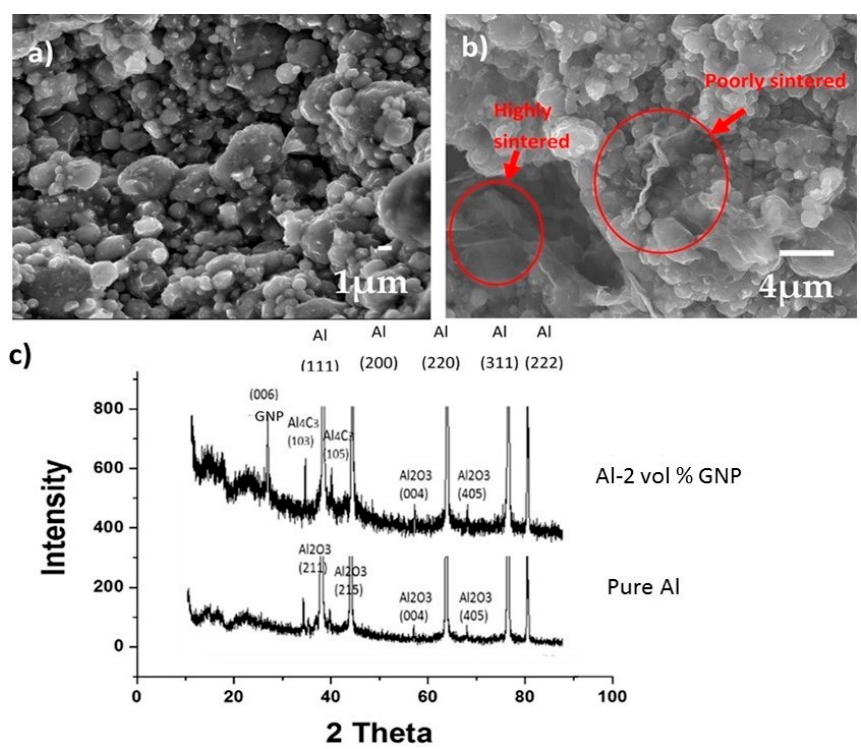
Figure 3. SEM images of the fracture surface of sintered ( a ) pure Al and ( b ) Al-2 vol % GNP. ( c ) X-ray diffraction of the sintered pellets.